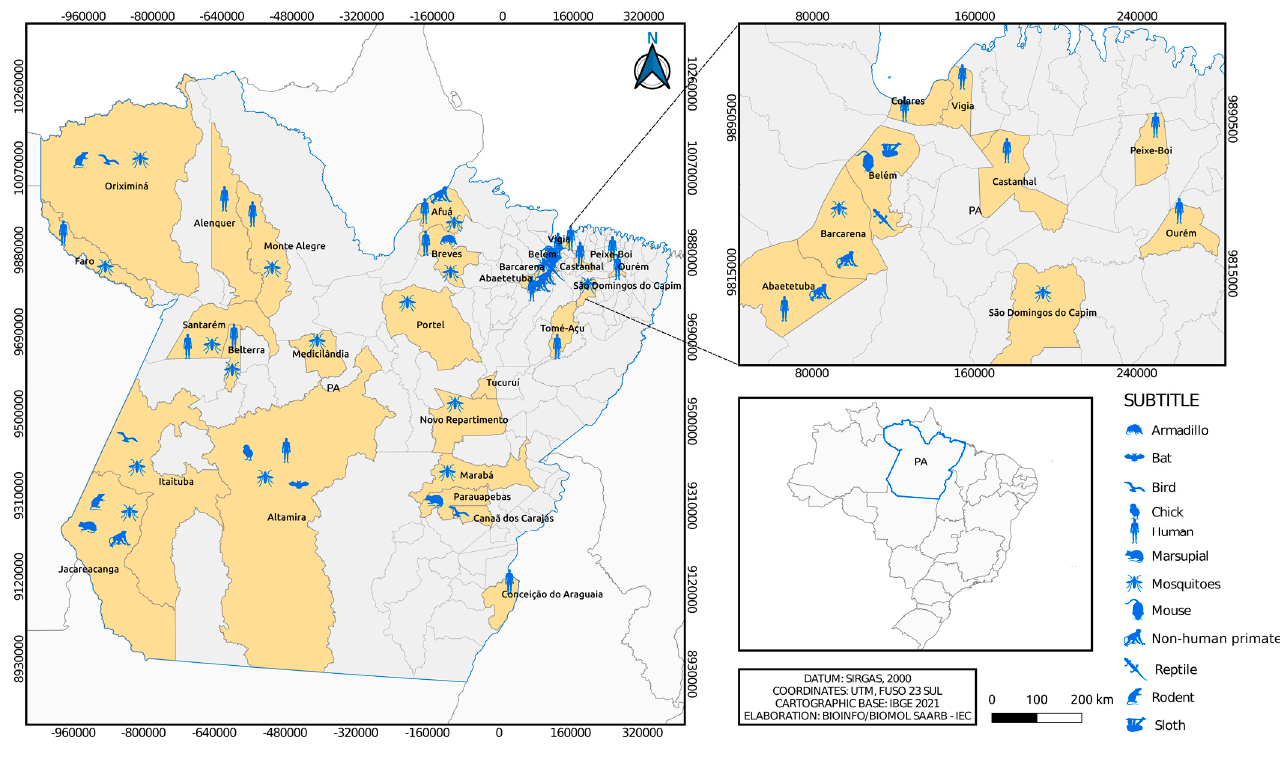
Figure 3. Municipalities in Pará state where fl aviviruses were isolated over 6 decades by the SAARB/IEC.